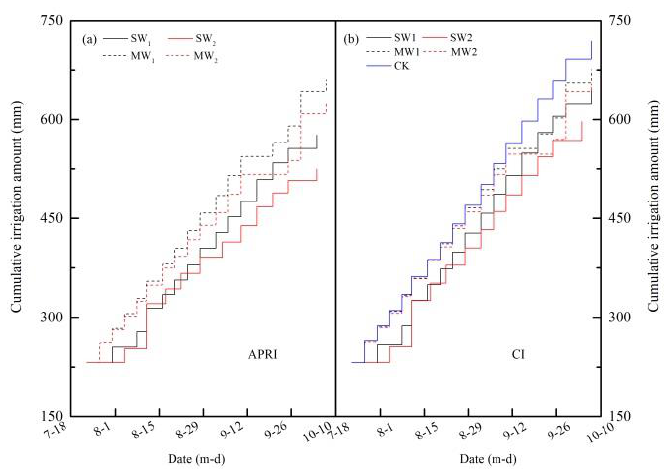
Figure 3. Irrigation schedule during the maize growing seasons under APRI ( a ) and CI ( b ).